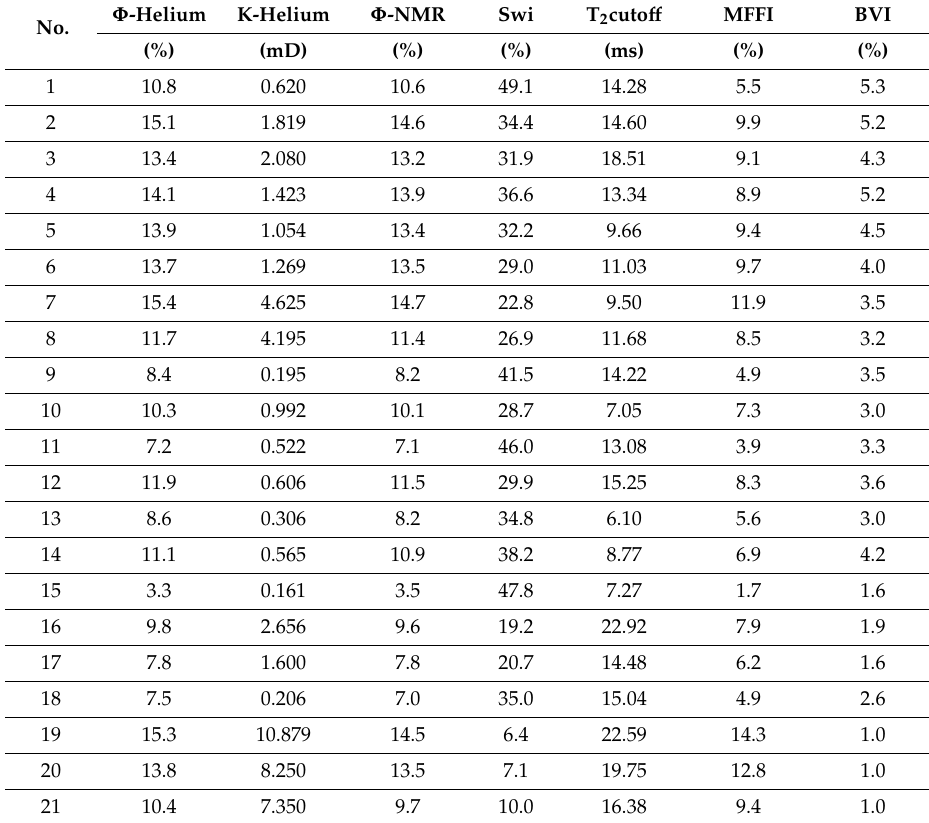
in Table 1. The data of 13 core samples from the He3 reservoir in the JX well are listed in Table 3. Table 1. Core physical property parameters obtained by nuclear magnetic resonance (NMR) experiments. Φ -Helium No.